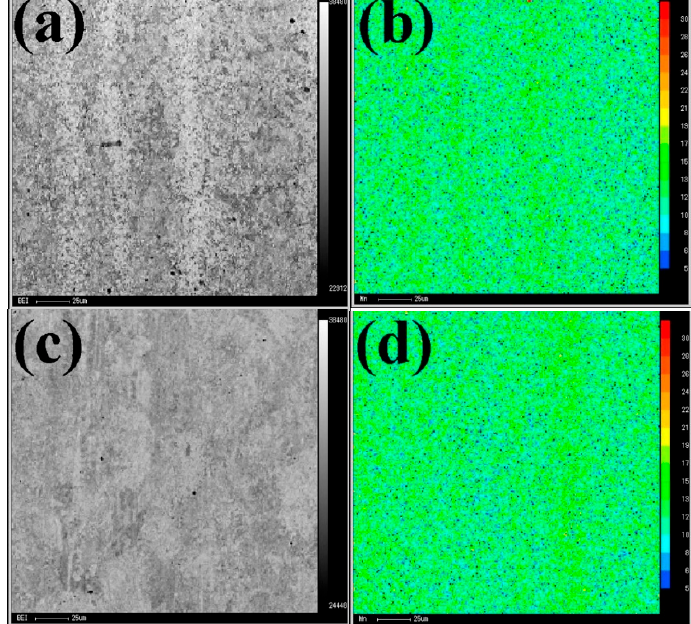
Figure 6. EPMA (Electron Probe Microanalyzer) elemental distribution maps in banded structures: ( a ) backscattered electron image (BEI) of banded structure1; ( b ) distribution of manganese within banded structure1; ( c ) BEI of banded structure2; and ( d ) distribution of manganese within banded structure2.